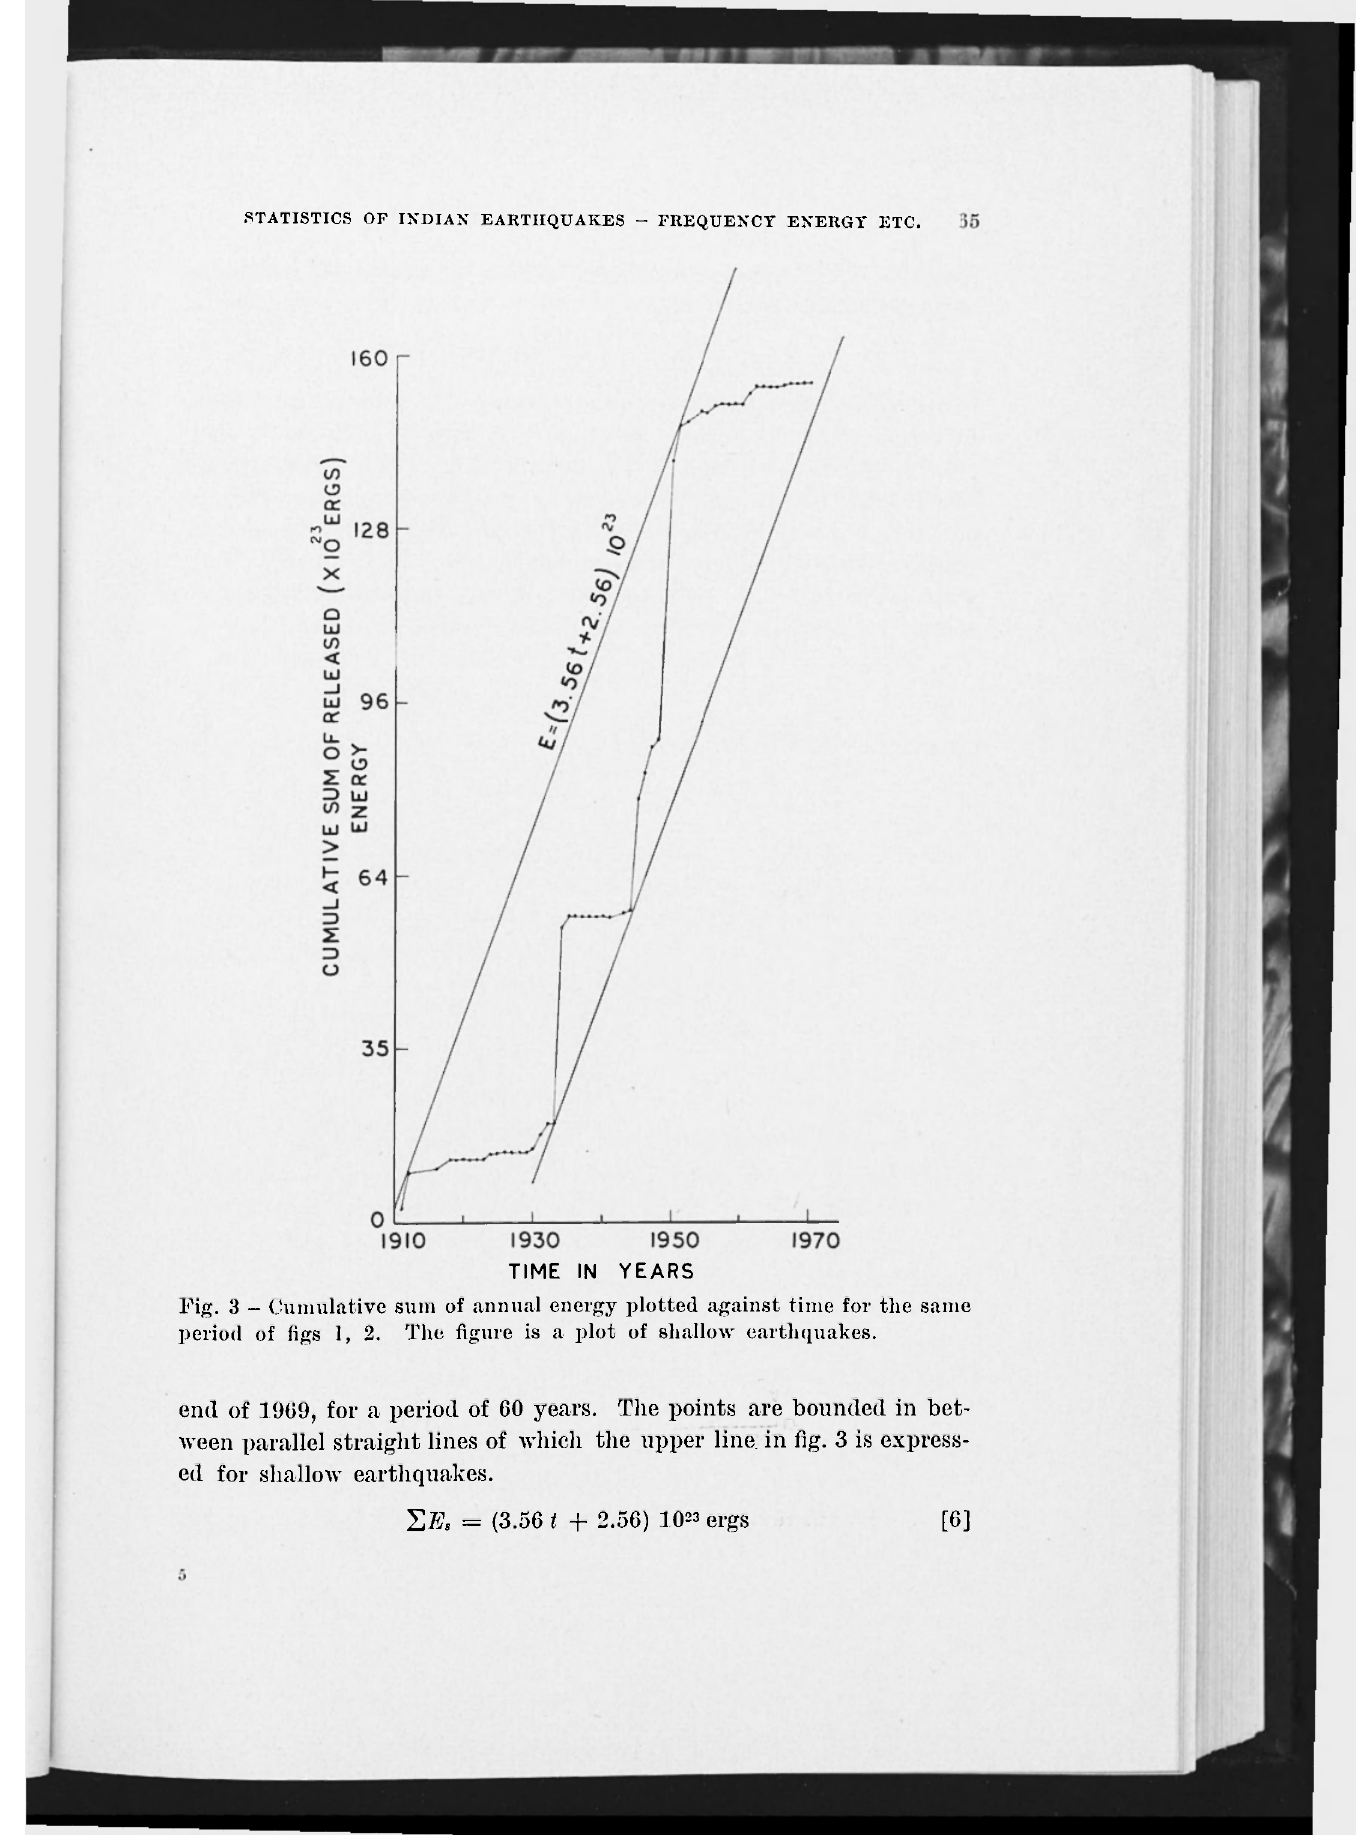
end of 1909, for a period of 60 years. The points are bounded in bet- ween parallel straight lines of which the upper line, in fig. 3 is express- ed for shallow